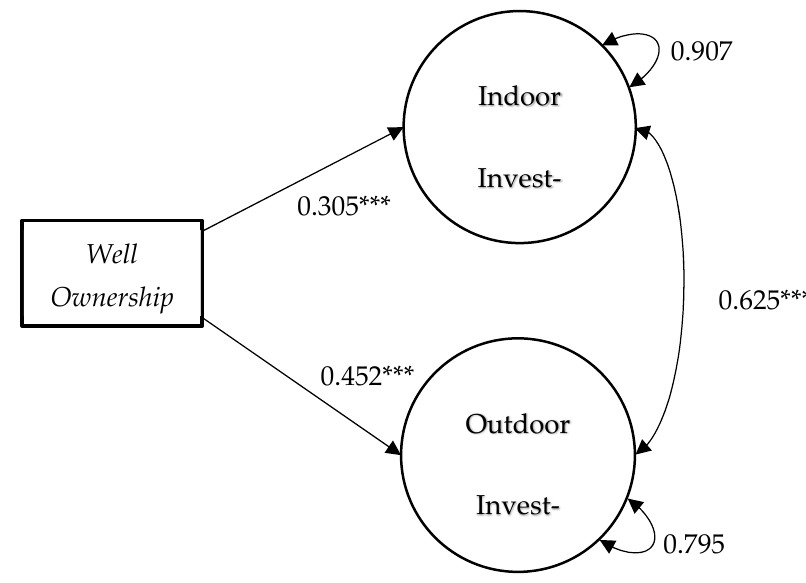
Figure 2. Model of owning water-saving appliances for indoor and outdoor usage regressed on well ownership ( n = 847). CFI: comparative fit index; RMSEA: root mean square error of approximation.